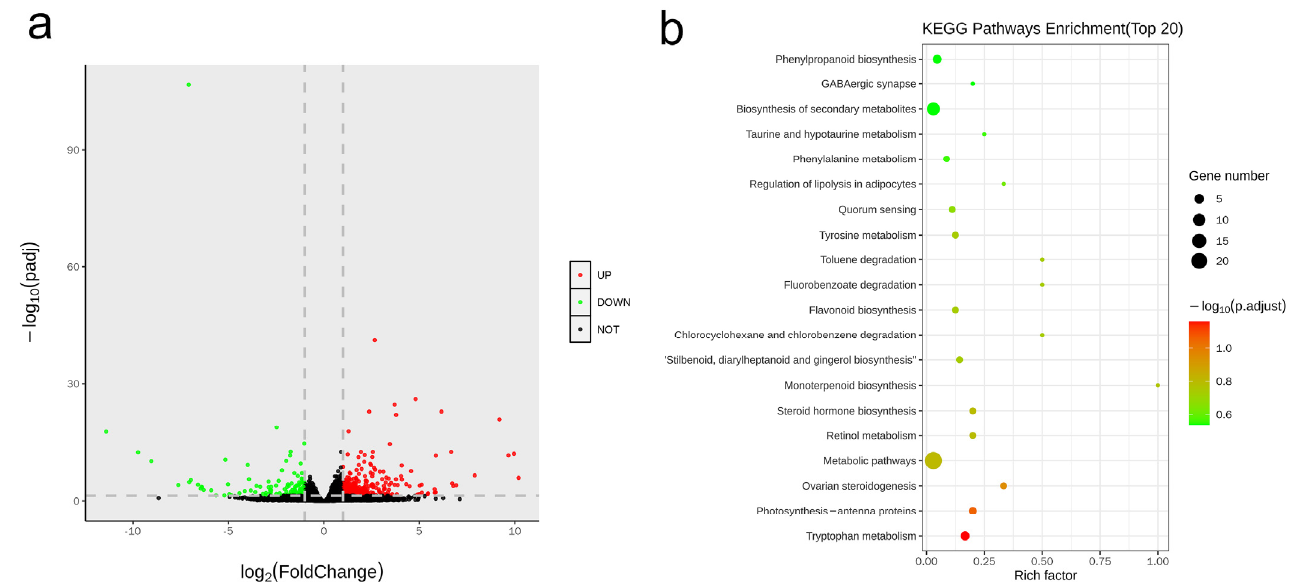
Figure 6. Transcriptome analysis between WT and mt mutant. ( a ) Volcano map of differentially expressed genes (DEGs). Red dots indicate the up-regulated genes, green dots indicate the down-regulated genes, and black dots indicate no differentially expressed genes. ( b ) KEGG enrichment analysis of DEGs. The X -axis is the enrichment factor score, and the Y axis is the enriched pathways. The dot size indicates the number of genes, and the color represents the value of Padj.